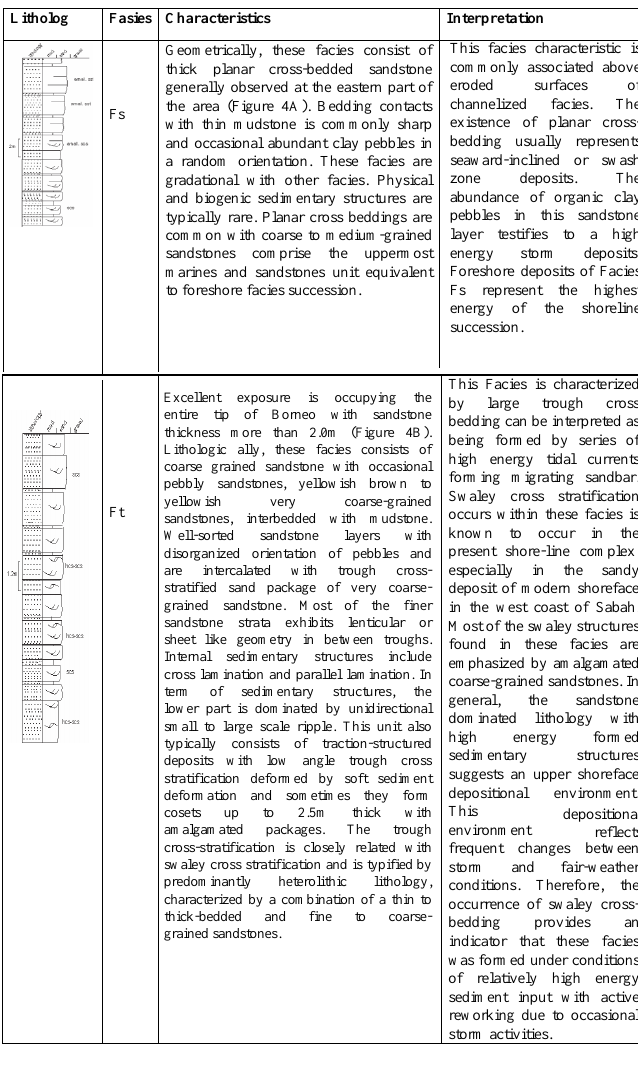
Geological Map of Sabah showing the location of the study area in